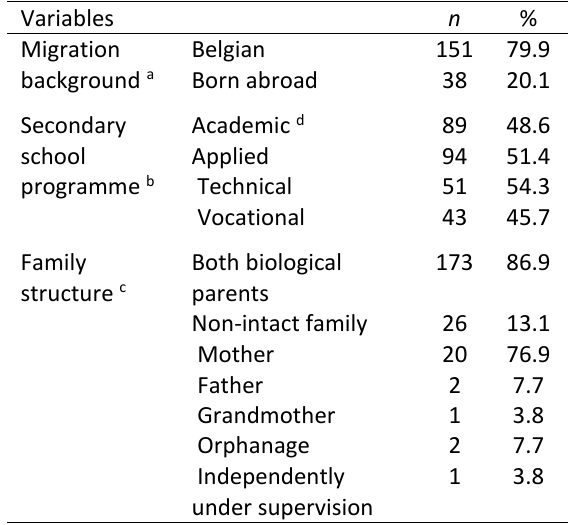
Table 1. Additional descriptive statistics of the sample ( N =